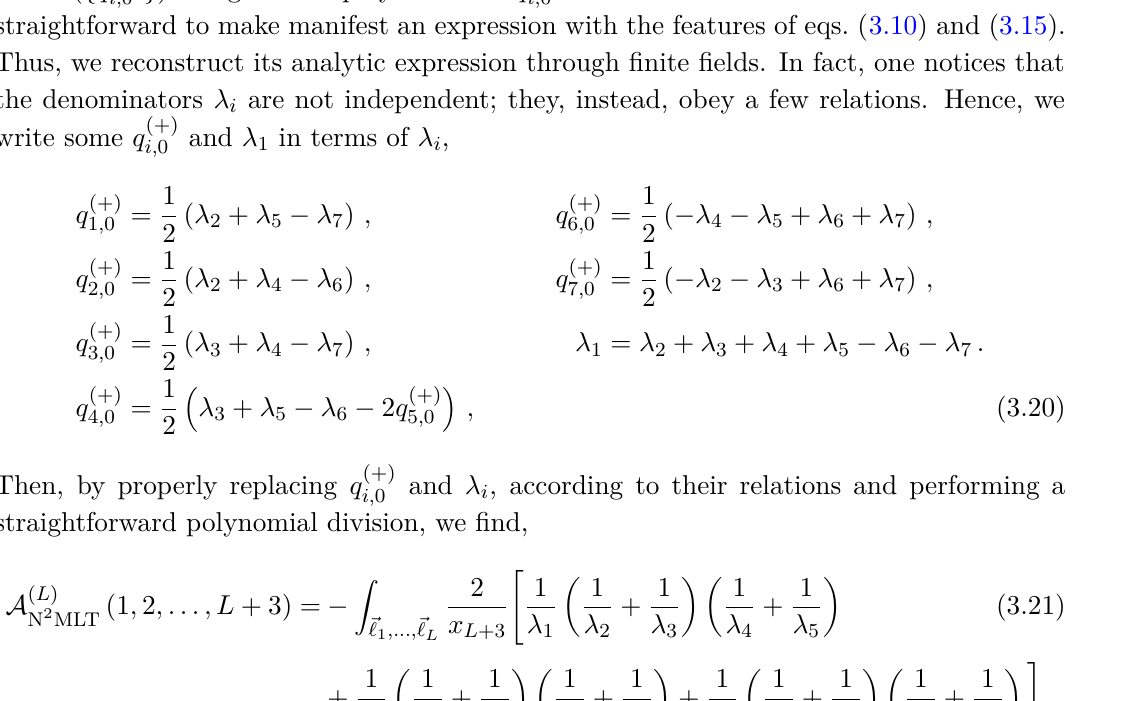
. From the structure of the latter it is i, 0